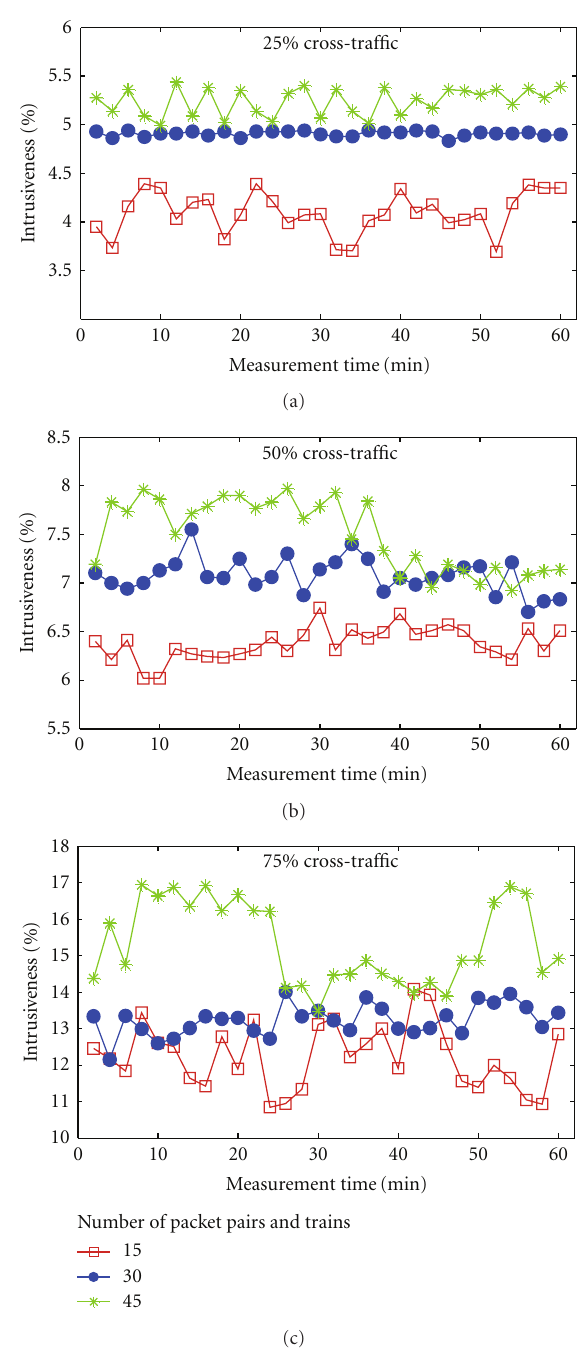
Figure 7: Intrusiveness for (a) 25%, (b) 50%, and (c) 75% cross- tra ffi